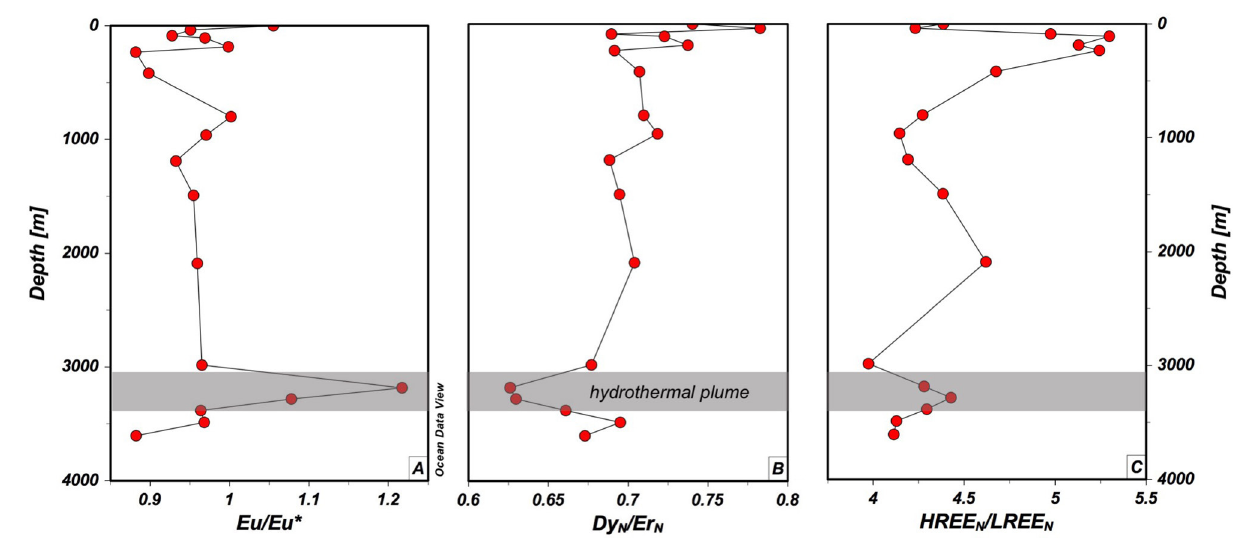
FIGURE 3 | Vertical distribution of Eu/Eu* (A) , PAAS (Taylor and McLennan, 1985) normalized Dy/Er (B) and HREE (Tm + Yb + Lu) over LREE (La + Pr + Nd) (C) and their associated anomalies within the TAG plume at station USGT11-16. The figure is designed with ODV ® software (Schlitzer, 2016a).